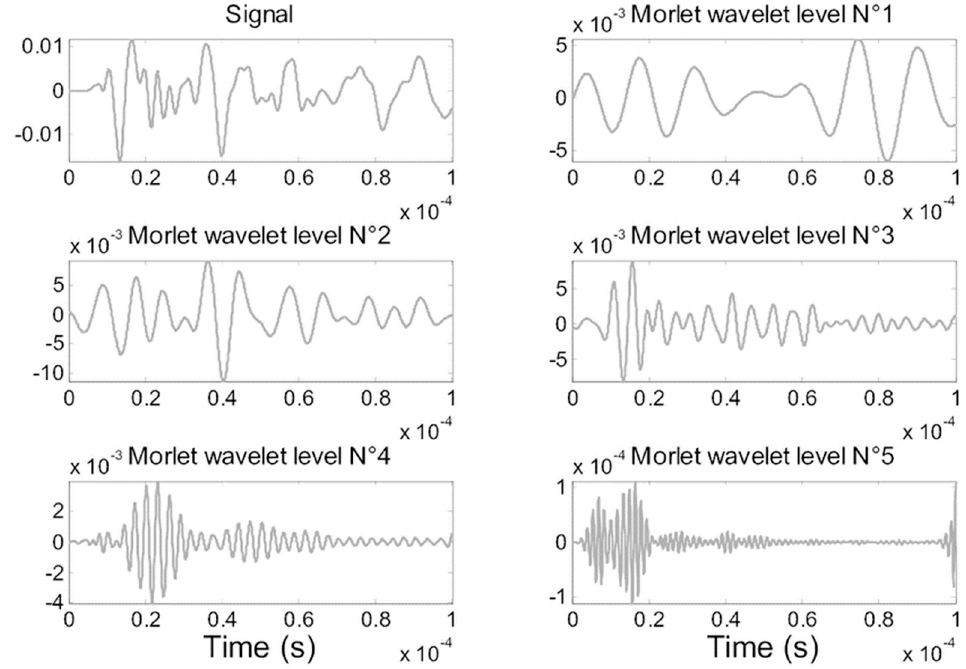
Figure 5. Discrete wavelet transform (with different decomposition level) of the simulated ultrasonic signal.